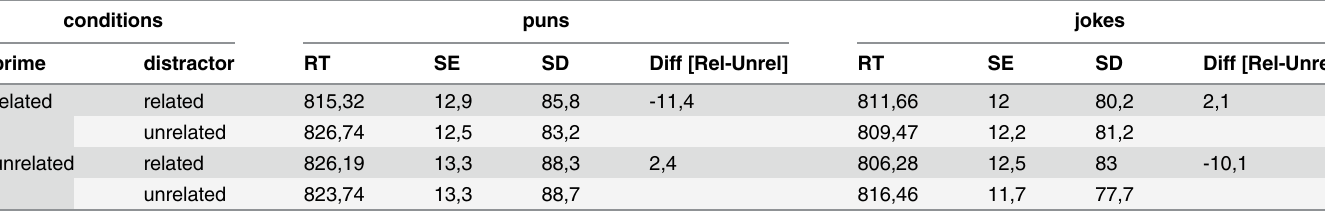
Table 1. Mean naming latencies (RTs, in milliseconds), standard errors of means (SEs), and standard deviations (SDs) for the prime and distractor word condition separated for both groups.